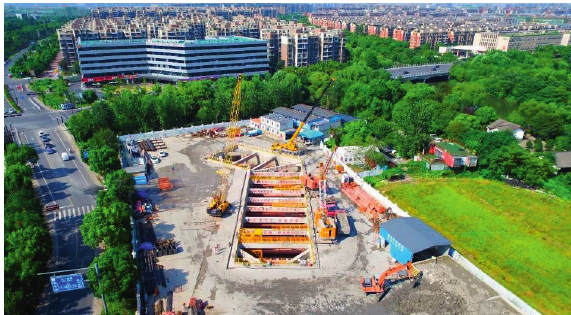
Figure 2: Close view of the investigated excavation.